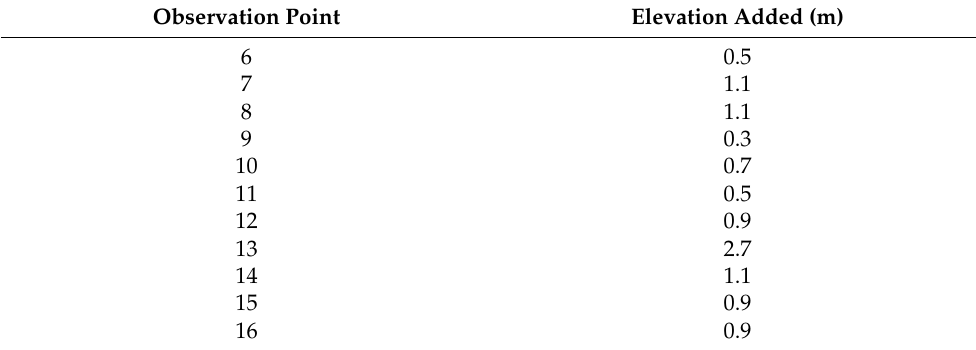
Table 4. Simulated elevation added to